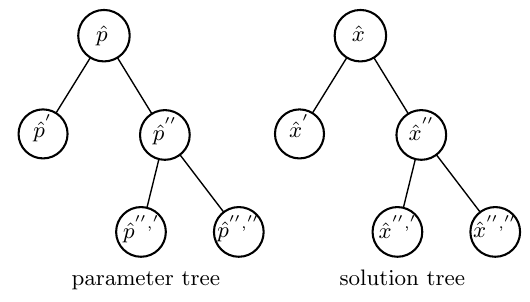
Figure 7: Affine transient simulation with merge strategy “Merge each”